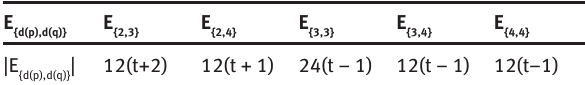
Table 7: The partation of the edges of MOF degrees of end